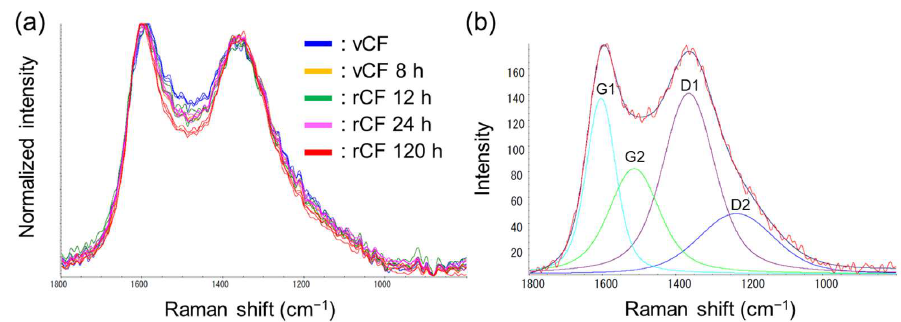
Figure A5. AFM shape images and phase images of vCF and rCF surface taken from the observation area 2 μm × 2 μm.